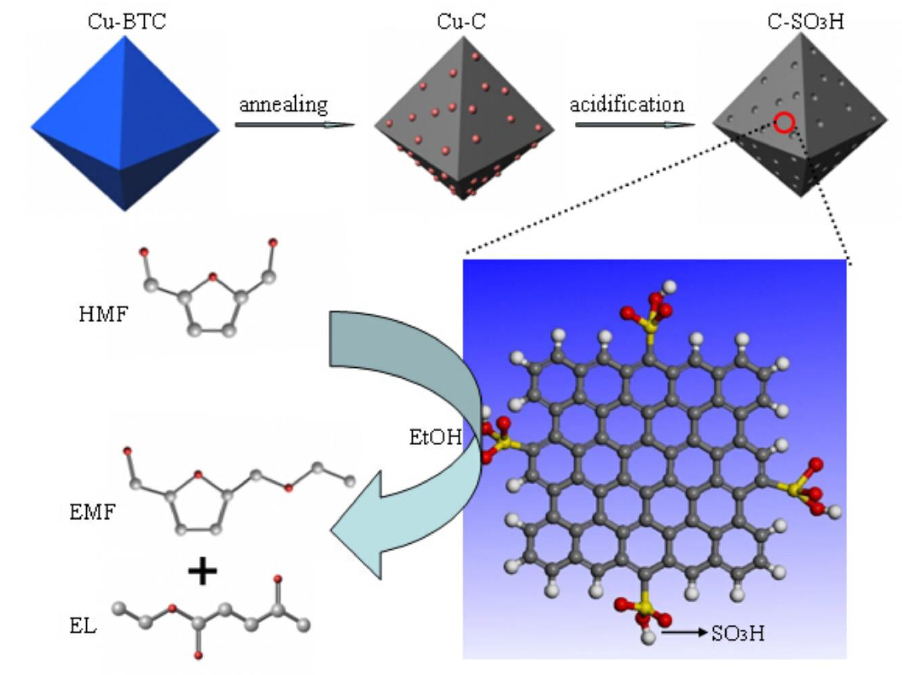
Figure 1. Schematic illustration of the synthesis and catalysis procedure.